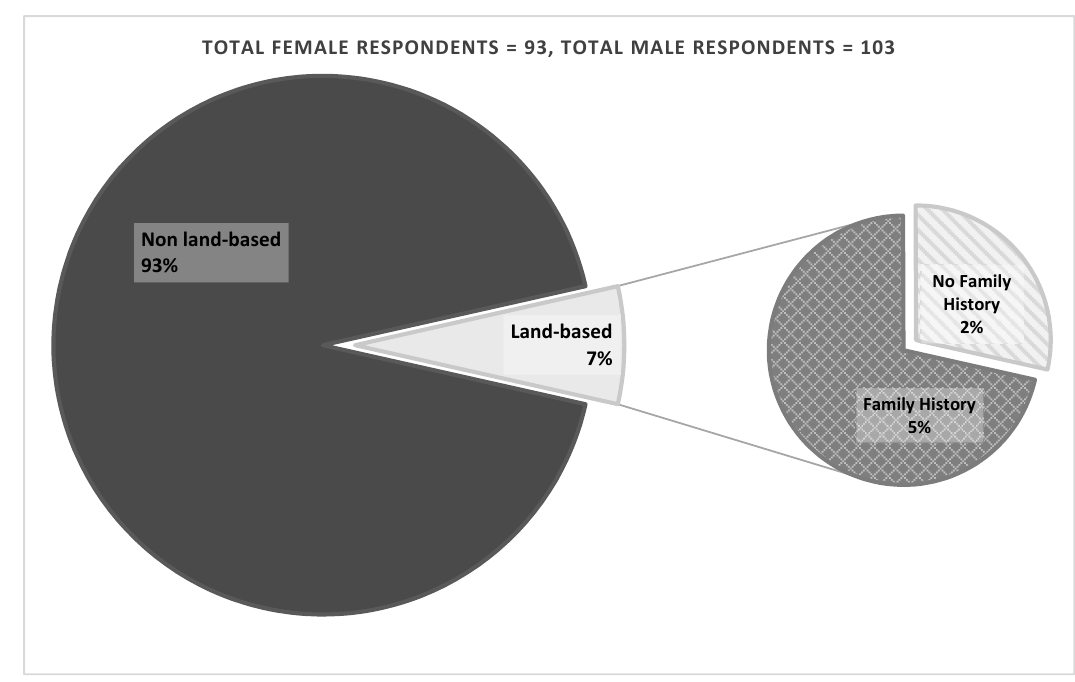
Figure 4. Youth-held plans to pursue land-based vs. non land-based livelihoods.